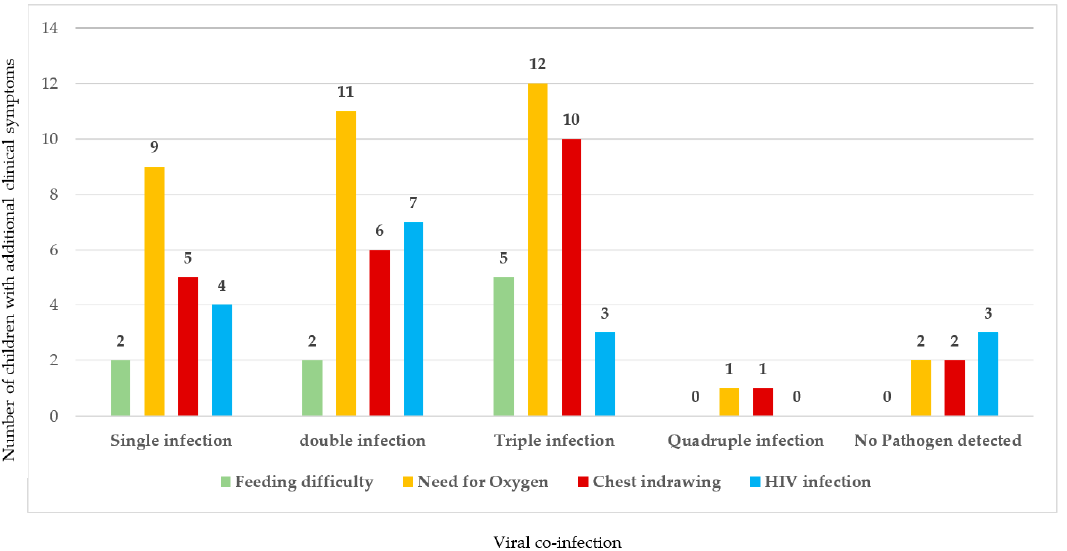
Figure 2. Estimate of clinical symptoms versus viral co-infections. 3.4. Profile of Pathogens Detected during Each Wave of the COVID-19 Infection Of the 28 children included during each period (second wave, the period between, and the third wave of the COVID-19 infection), a total of n = 26, n = 26, and n = 22 children tested positive for at least one viral pathogen, respectively, and no targeted pathogens were detected in n = 2, n = 2, and n = 6 children, respectively. The profile of pathogens detected during each period investigated are depicted in Figure 3.